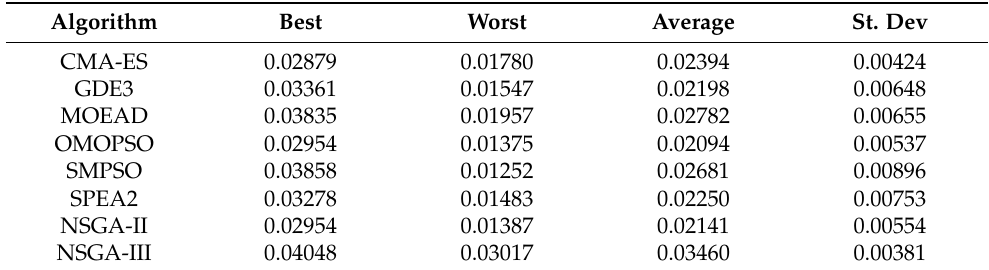
Table 3. Optimum score of the NSGA-III in comparison with other evolutionary algorithms.